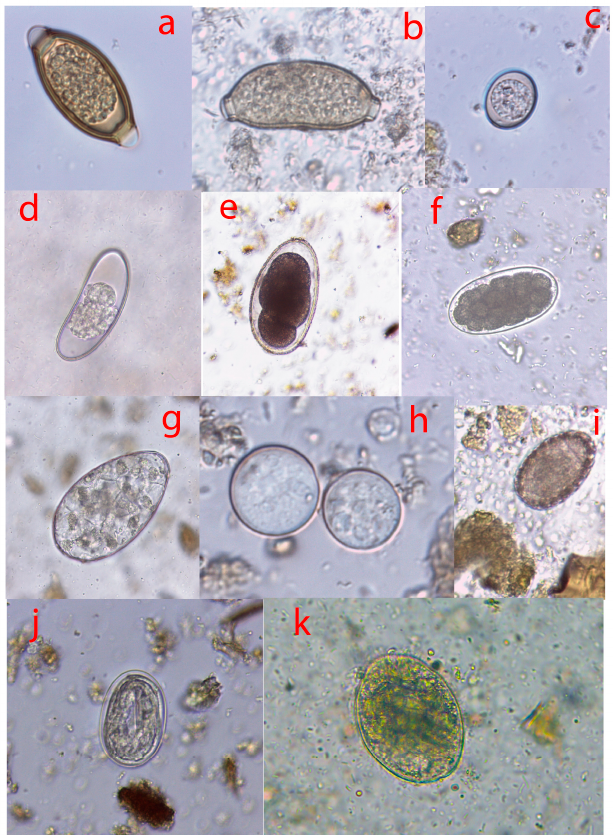
Figure 2. Micrographs of gastrointestinal parasite eggs isolated from different bushmeat in the Zadie department. ( a ) Trichuris spp.; ( b ) Capillaria spp.; ( c ) Eimeria spp.; ( d ) Enterobius spp.; ( e ) Mammomonogamus spp.; ( f ) Strongylid egg; ( g ) Fasciola spp.; ( h ) Entamoeba spp.; ( i ) Ascaris spp.; ( j ) Strongyloïdes spp.; ( k ) Balantidium spp.